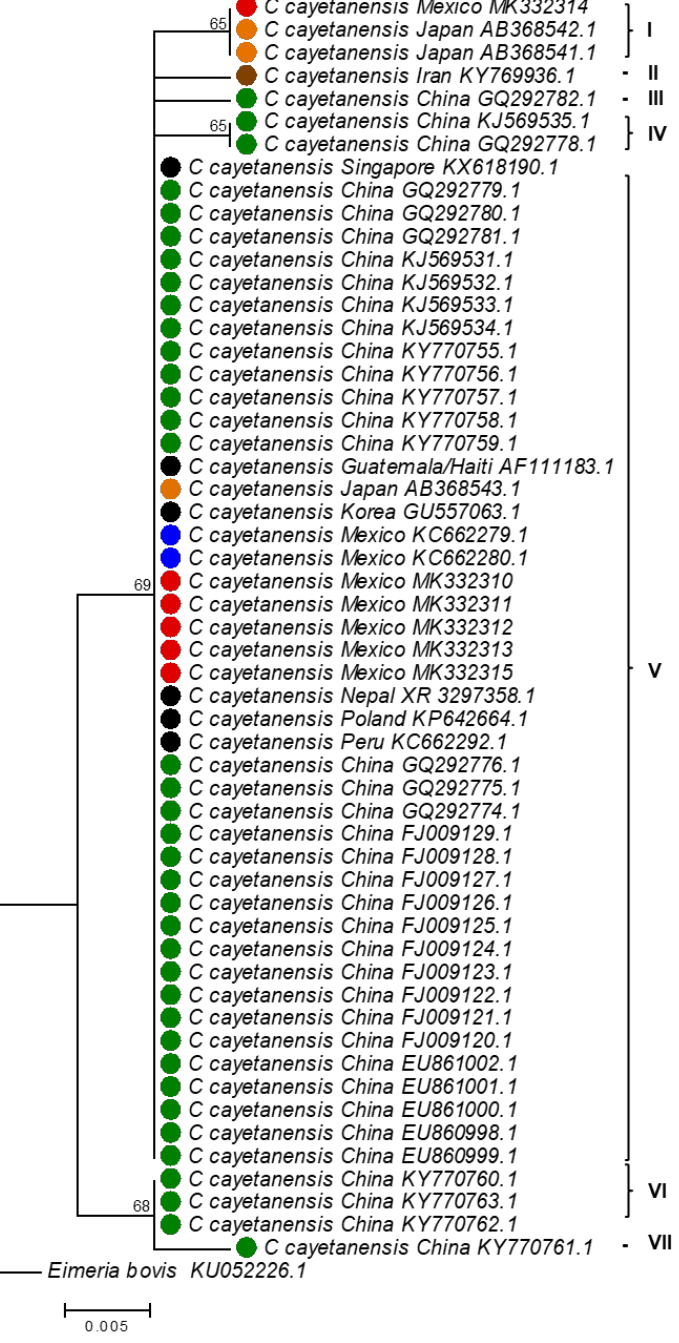
Figure 4. Phylogenetic analysis of Cyclospora cayetanensis 18S rRNA genes. Red circles: sequences from Mexico (present study); orange circles: sequences from Japan; brown circle: sequence from Iran; black circles: sequences from Singapore, Korea, Nepal, Guatemala/Haiti, Poland, and Peru; green circles: sequences from China. Roman numbers (I–VII) depict different genotypes identified in the present study. Countries of origin and accession numbers are provided for each sequence.